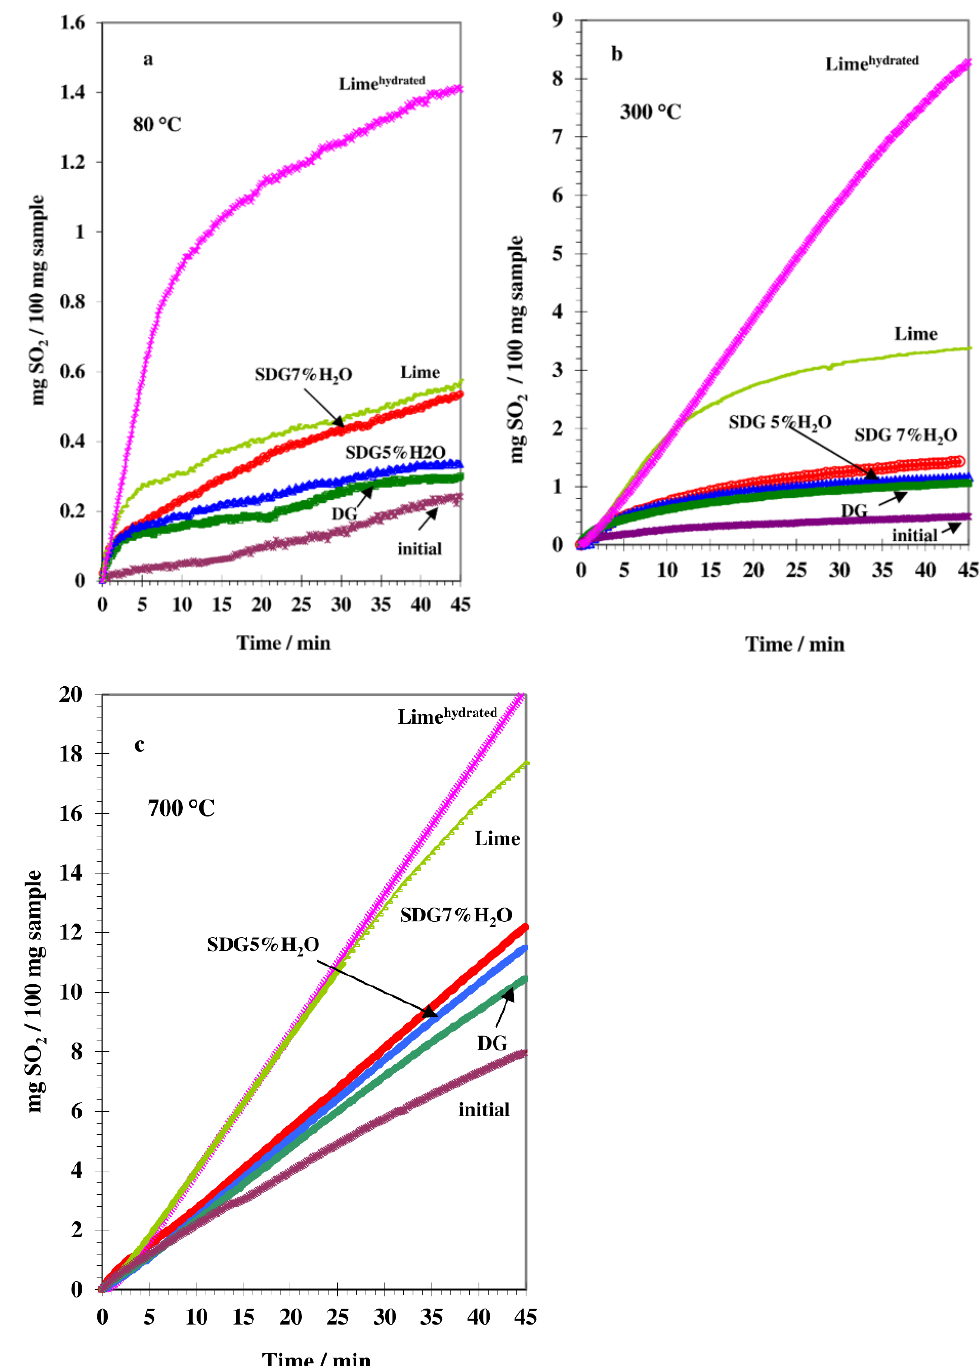
Figure 6. Dependence of SO 2 binding capacity (mg SO 2 per 100 mg of sample) of sorbents on contact time between solid and gaseous phases at 80 °C ( a ), 300 °C ( b ) and 700 °C ( c ).